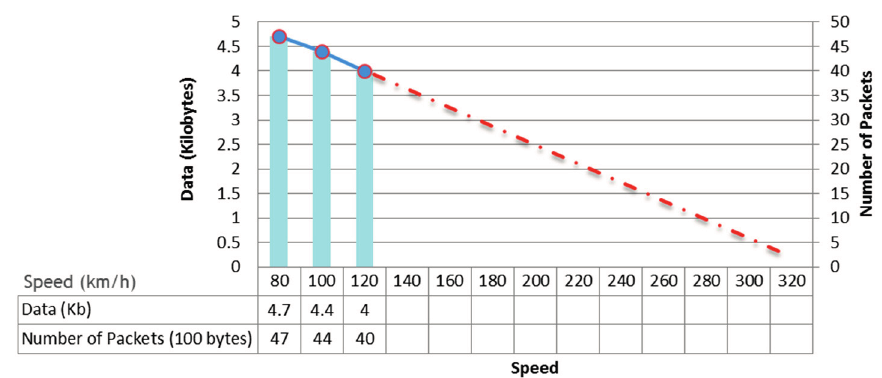
Figure 15. Results of the transmission and mobility (868 MHz and 0 dBi antennas).